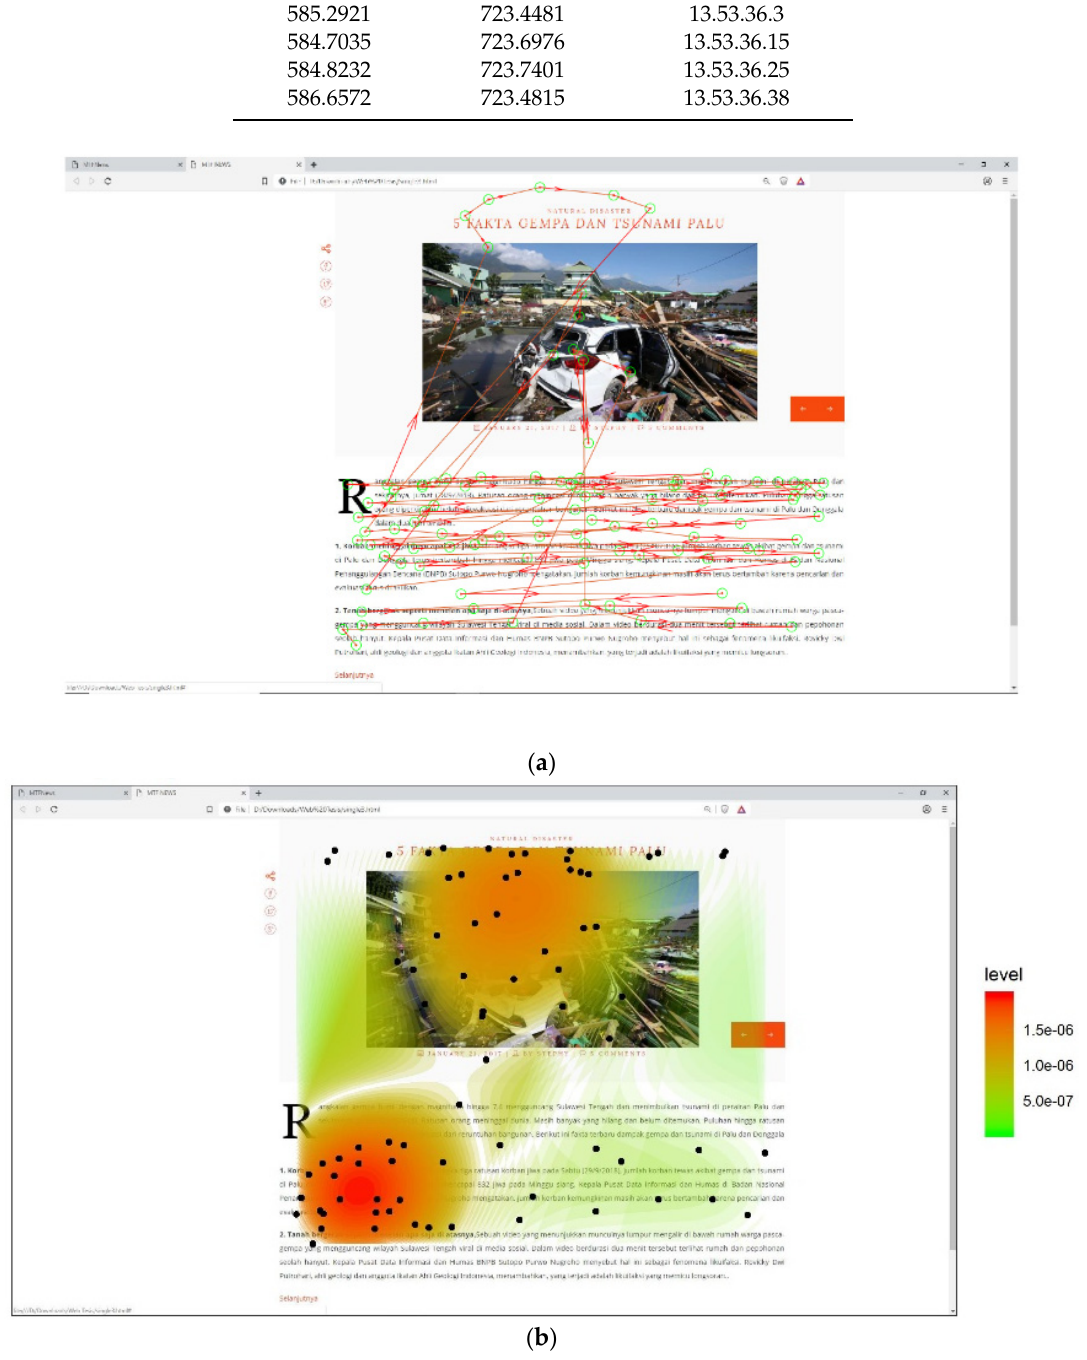
Figure 1. ( a ) Example of gaze plot; ( b ) Example of heat map.